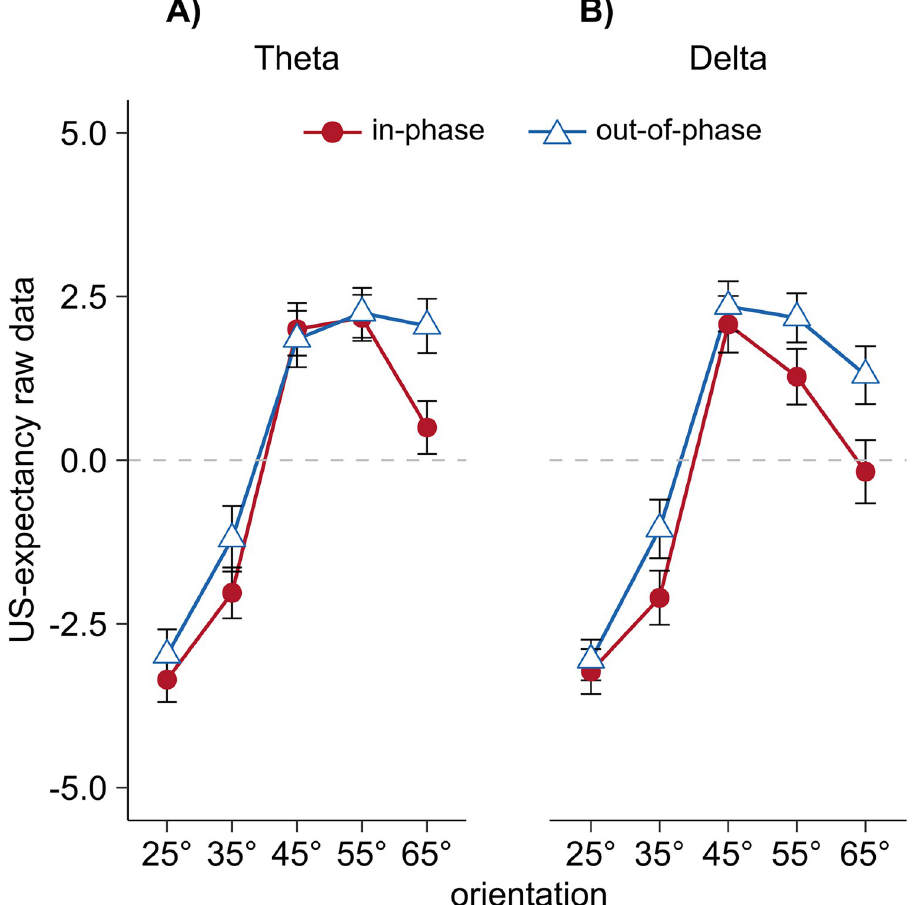
Fig 4. Raw US-expectancy data. Raw US-expectancy ratings separated for frequency (theta vs. delta) and synchronization condition (in-phase vs. out-of-phase). US-expectancies were collected as described in caption of Fig 3 and the Materials and Methods section (Dependent variables) . Each data point represents mean US-expectancy ratings for each CS orientation over participants, separately for frequency and synchronization condition. Error bars show ± 1 SEM. S1 and S2 Figs shows discrimination indices (CS+ minus the average of all CS-) and estimation statistics for z- transformed US-expectancy ratings. Discrimination indices were calculated for the comparison of in-phase vs. out-of- phase across frequency as well as separately for theta and delta frequency. The estimation plots in S1 and S2 Figs depict the estimation statistics including the individual values as well as effect sizes (Hedge’s g) as a bootstrap confidence interval (5000 samples [33]). S1 Fig shows the comparison of both synchronization conditions across the mean of theta and delta frequency, S2 Fig presents the comparison between in-phase and out-of-phase synchronization within each frequency (theta vs.